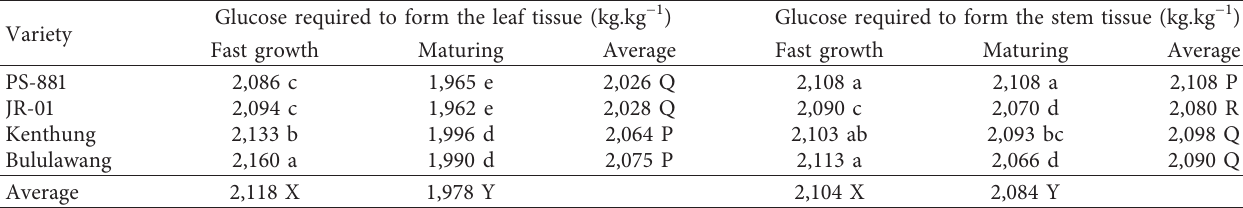
Table 2: Glucose requirements during the fast-growth and maturing phase.